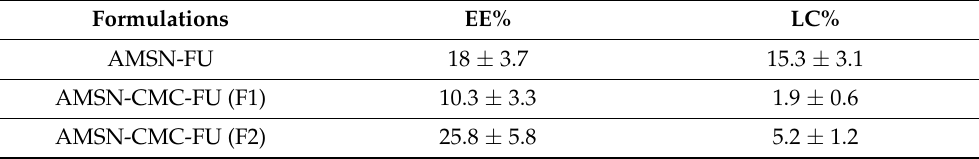
Table 1. Encapsulation efficiency (EE%) and drug loading (LC%) of AMSN-FU, AMSN-CMC-FU (F1), and AMSN-CMC-FU (F2). Results are the mean of three measurements with standard deviations (Mean ± SD, n =